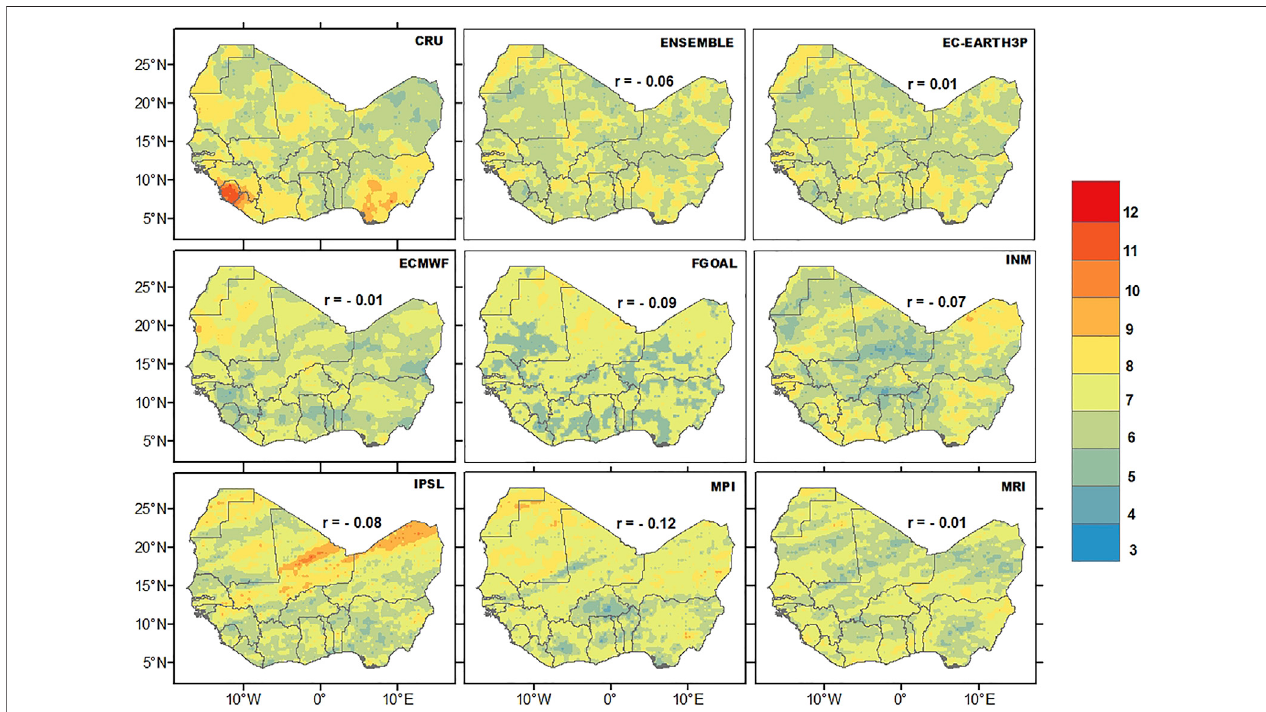
FIGURE 12 | Same as Figure 11 but for the frequency of agricultural drought